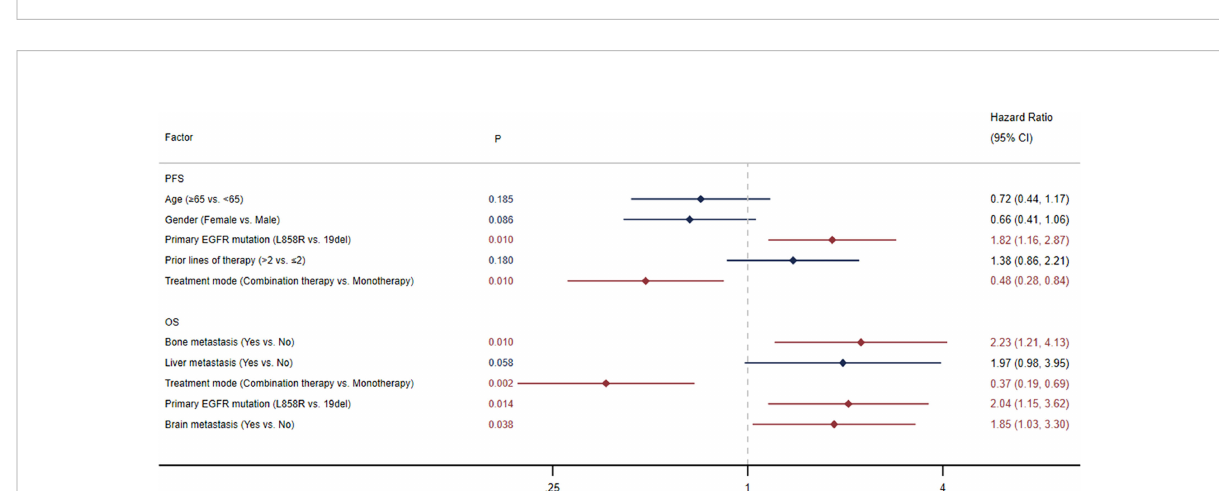
FIGURE 4 Multivariate Cox regression analysis for progression-free survival (PFS) and overall survival